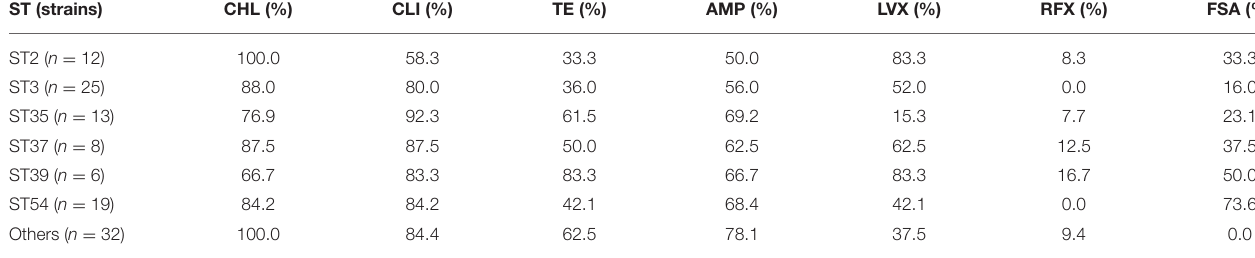
TABLE 4 | The antibiotic resistance of C. difficile isolates according to ST types. ST (strains)